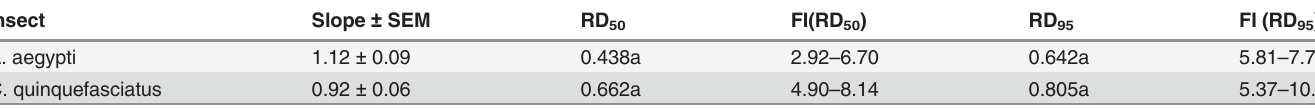
Table 5. Repellent activity of S . guianensis essential oil against A . aegypti and C . quinquefasciatus .